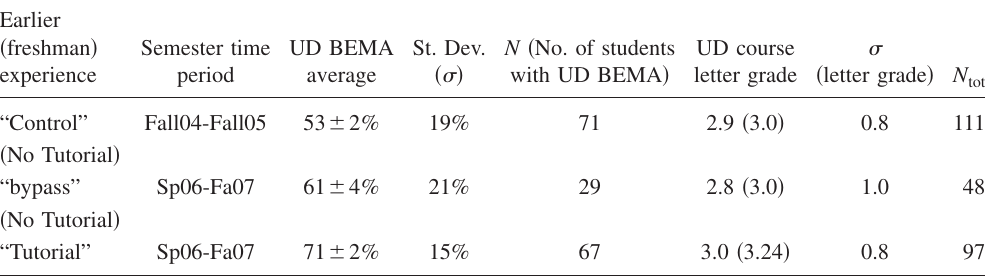
TABLE I. Summary of upper-division (cid:1) UD (cid:2) BEMA scores, and course grades (cid:1) 0–4 (cid:2) over seven semesters of data for both Physics 301 and 302. When scores for 301 and 302 are available, we average them for this table (cid:1) Course grade in parentheses is calculated for just the subset of students who took the upper-division BEMA (cid:2) .